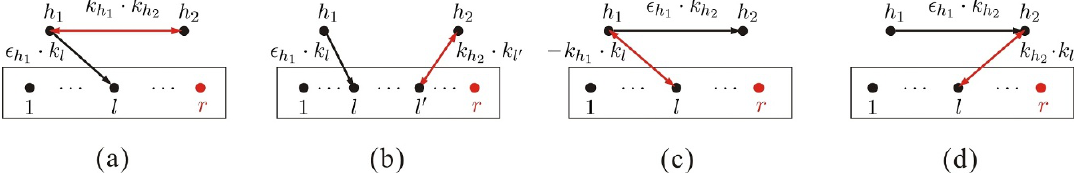
Figure 25 . Graphs (a) and (b) are those graphs F containing the skeleton F 0 = (cid:12)gure 24 (a). Graphs containing the skeleton F 0 = (cid:12)gure 24 (b) are given by (c) and